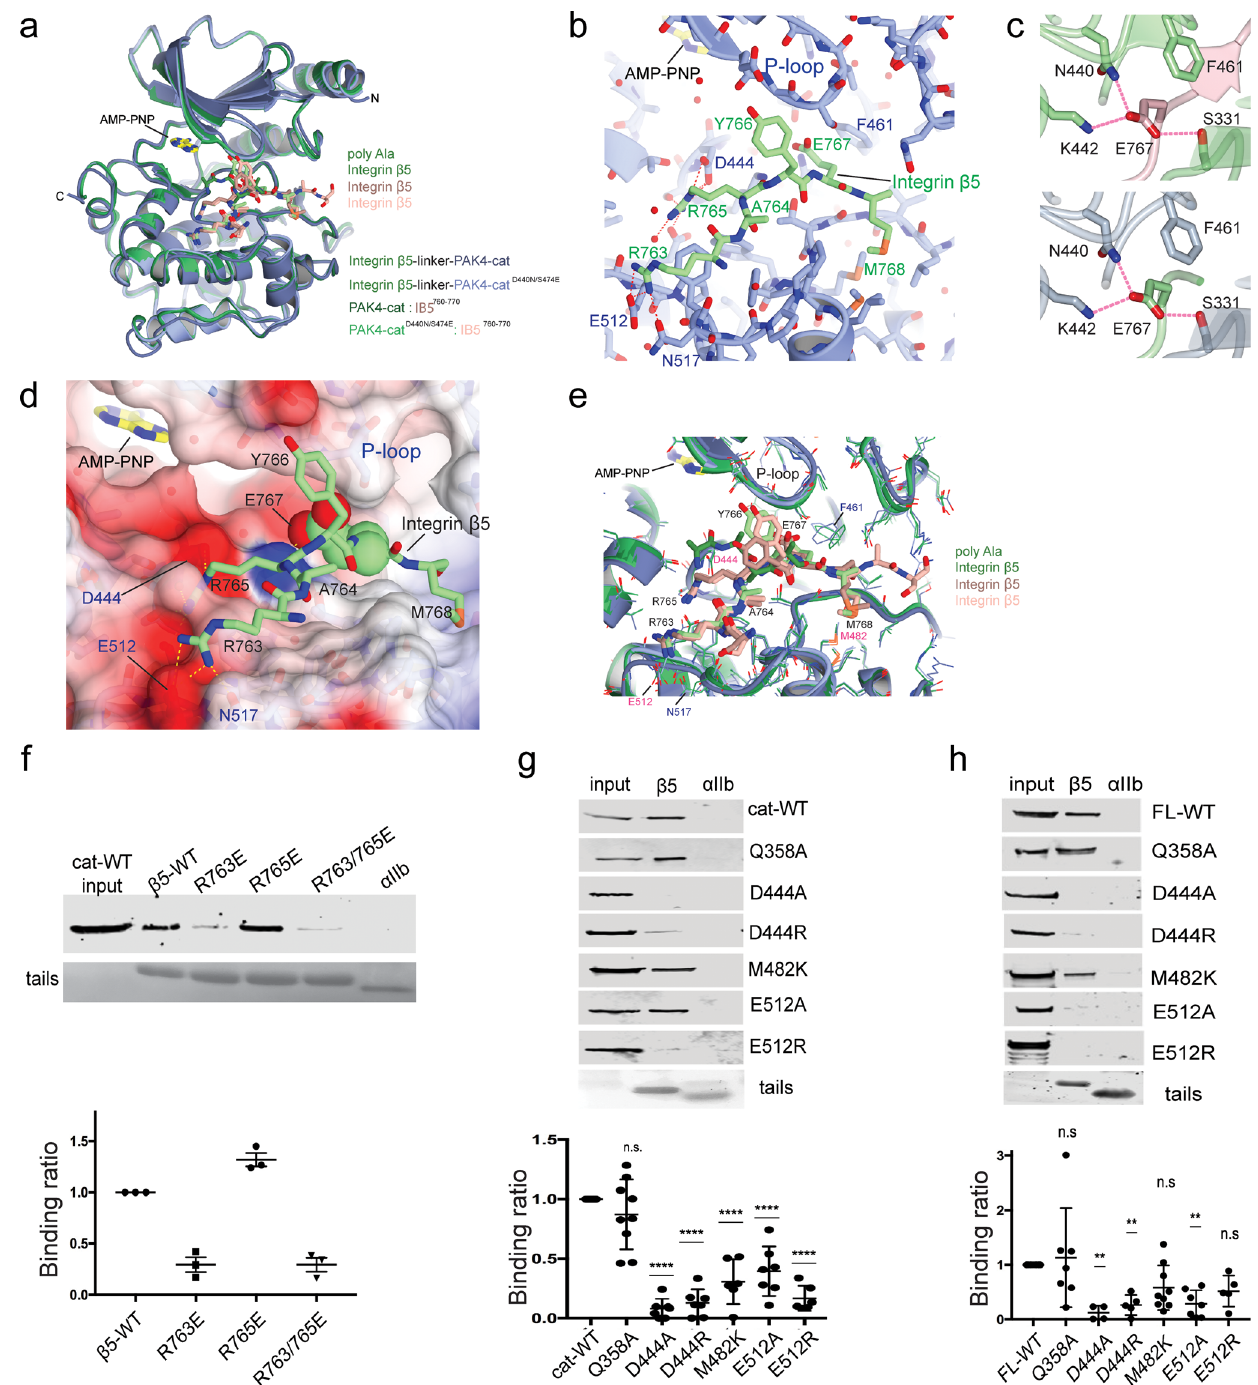
Fig. 4 Analysis of integrin β 5 interaction with PAK4. a Cartoon diagram of PAK4-integrin β 5 structures superposed on the kinase C-lobes. b Details of integrin β 5-PAK4 interaction. Salt bridges indicated by dashed red lines. c Illustration of the pose of Glu767 in the D440N mutant structures (top, bottom) Glu767 coordinates N440, K442, and Ser331. d Surface electrostatics of PAK4 with bound integrin β 5 in green. Glu767 β 5 is located at the phosphoacceptor residue site. e Close up superposition of the integrin binding site. Residues mutated in panels f – h are indicated. f Pull down of overexpressed GFP-tagged PAK4 catalytic domain with recombinant puri fi ed wild-type and mutated integrin β 5 tails immobilized on nickel beads. Bound protein was detected by immunoblotting with anti-GFP antibodies. 3% of input lysate is shown in input lane. Tail loading was assessed by Coomassie staining. A representative experiment is shown in the upper panel with the quanti fi cation of three independent replicates (normalized to the wild-type β 5 tail) shown below. Mean ± s.d. Pull-down of wild-type and mutated PAK4 catalytic domain ( g ) and full-length PAK4 ( h ) with wild-type integrin β 5 was assessed as in ( f ). Representative experiments are shown in upper panels and the quanti fi cation of multiple independent replicates normalized to the wild-type PAK construct are shown below. Mean ± s.d. ( n ≥ 4). Signi fi cant difference from wild-type control calculated in one-way ANOVA with Dunnett ’ s multiple comparison test. Source data are provided as a Source Data fi le.